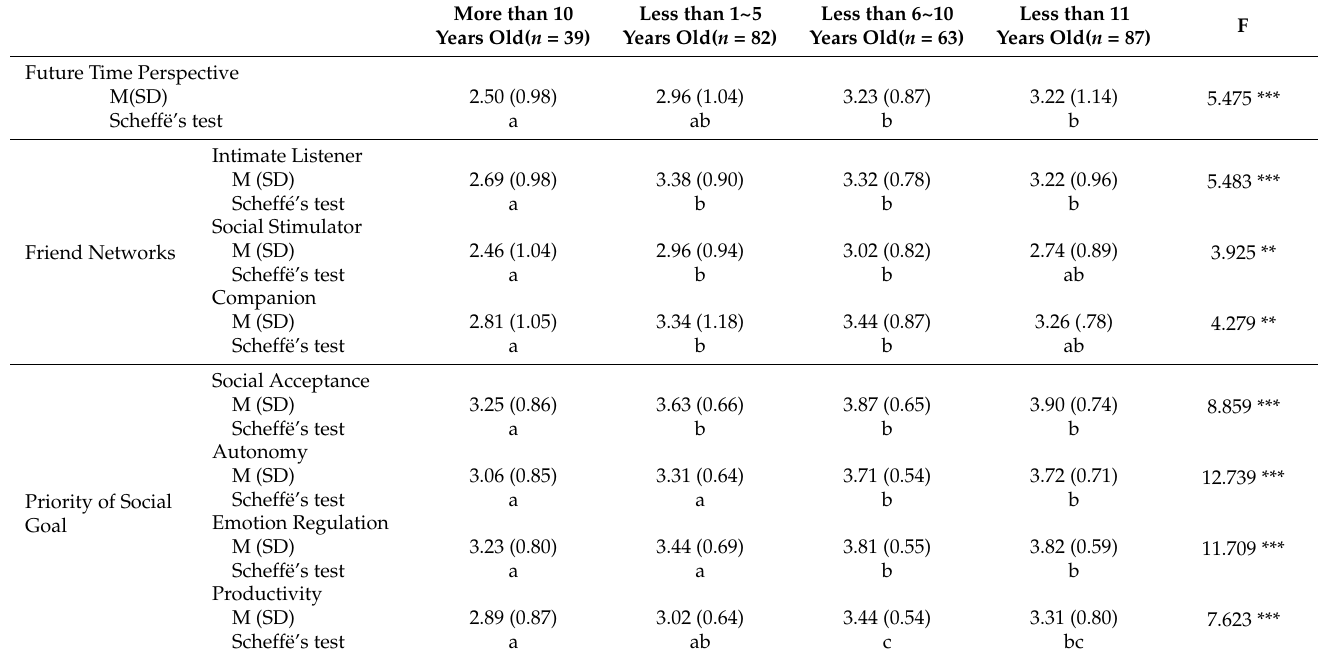
Table 2. Results of the one-way ANOVA and Scheffë’s post hoc